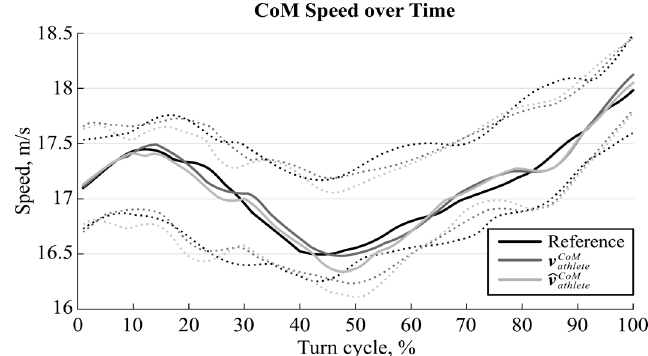
Figure 4. Reference speed (black) and estimated speed (dark and light grey) for the CoM. Solid lines are the median speed for all twelve turns at gate 7 analyzed and the dotted lines the 25th and 75th percentiles.